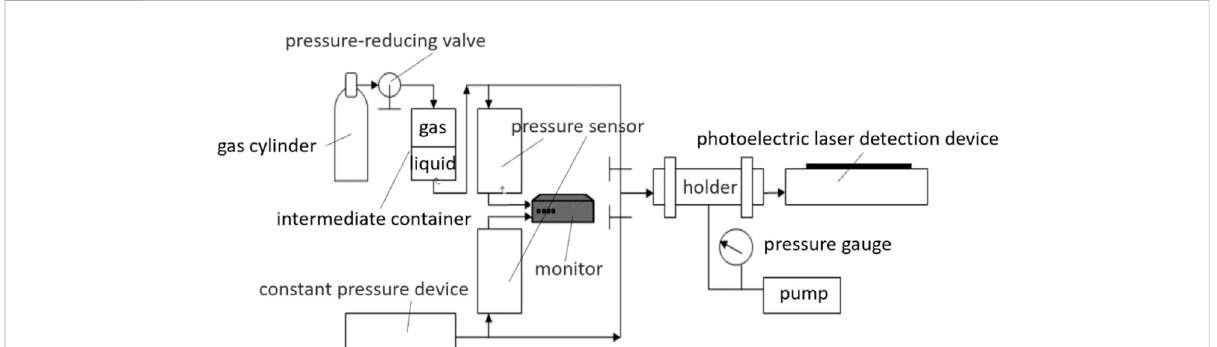
FIGURE 1 Nonlinear fl ow experiment.